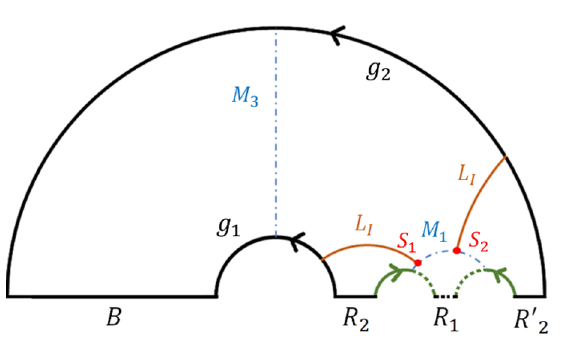
Figure 5 . This is a covering space depiction of the left half side of figure 4. Since we remove the entanglement wedge of R 1 in the original 3-side wormhole, the region surrounded by M 1 and dashed lines is thrown away in this fundamental region. The depiction of L I in figure 4 in this covering space consists of two brown arcs with intersection points on M 1 . The left arc can be transformed by γ 1 (A.3) to the outside of the fundamental region and smoothly connected to the right end of the right arc. The locations of the two intersection points on M 1 uniquely determine this type of geodesic